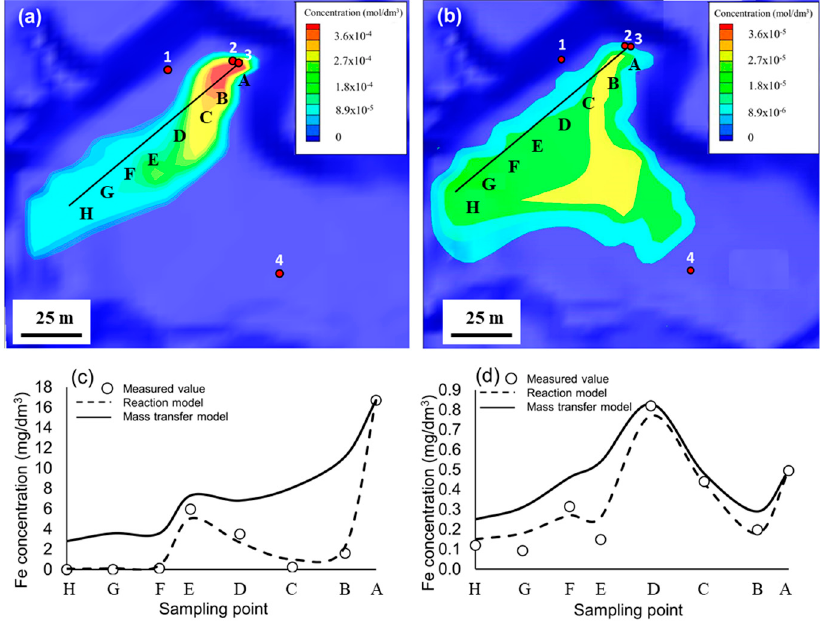
Figure 7. Simulation result: Distribution map of Fe concentrations ( a ) in summer, ( b ) in winter, and ( c , d ) measured Si concentrations on the lines A–H and the fitting results.